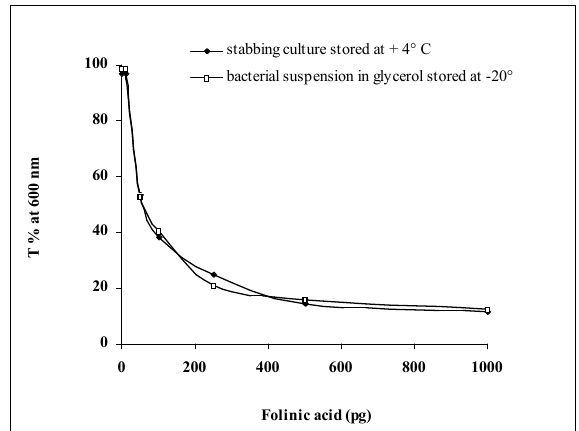
Figure 4. Growth response of two different type of stock bacteria; stabbing culture stored at +4 ° C and bacterial suspension in glycerol stored at -20 ° C (amounts of folinic acid were put into assay tubes of 3.9